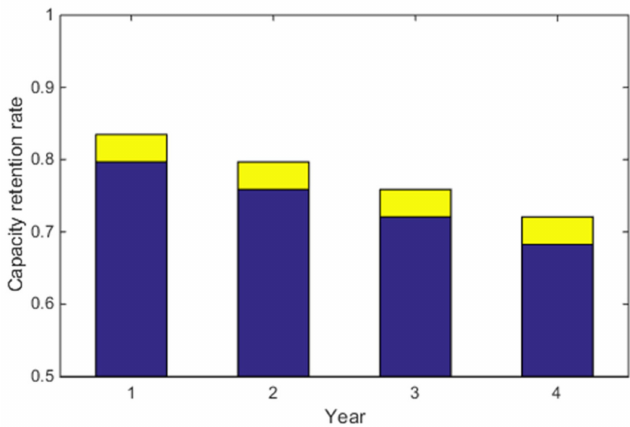
Figure 7. Storage battery capacity decays year by